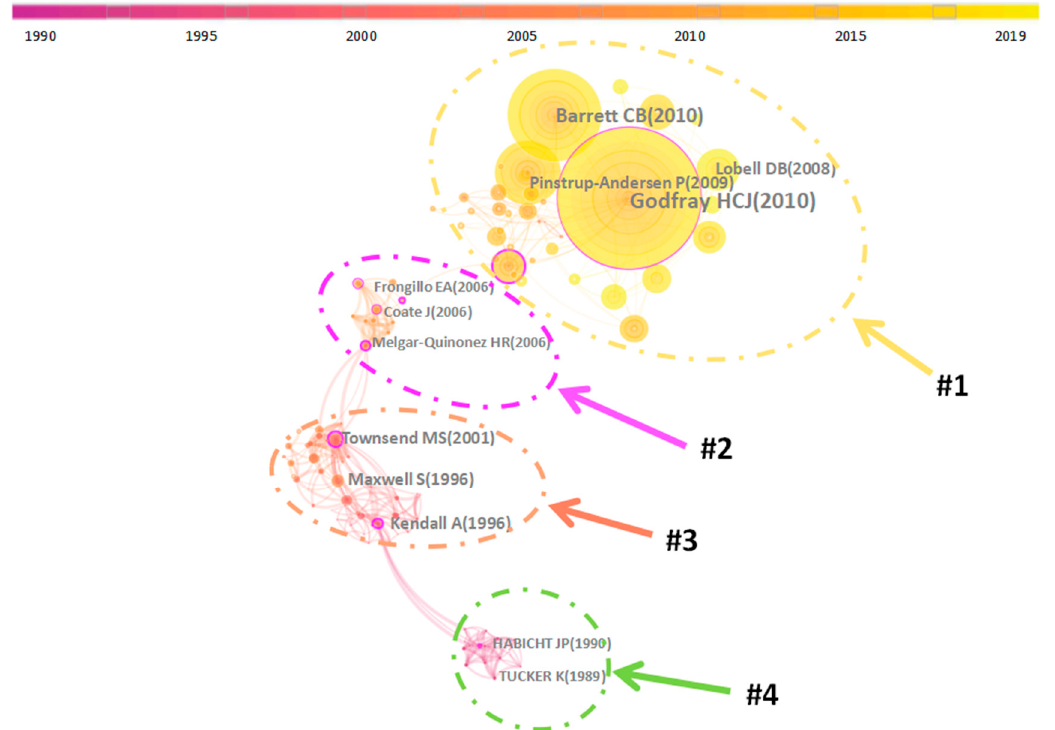
Figure 8. Co-citation network of food security.